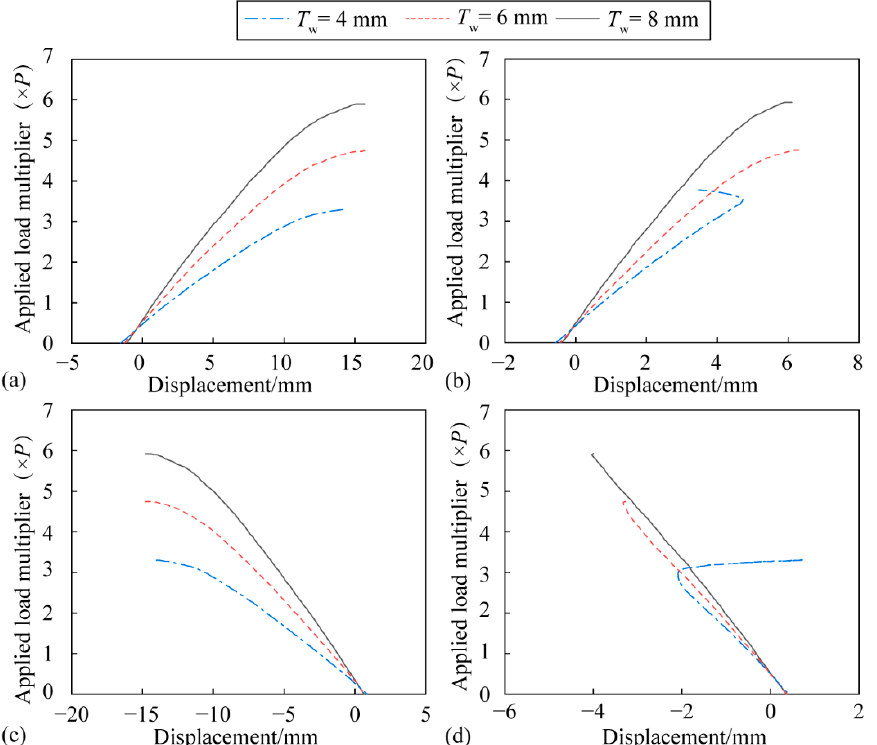
Figure 18. ( a ) Vertical displacement on the top flange, ( b ) horizontal displacement on the front web of the point in the juncture node zone, ( c ) vertical displacement on the top flange, ( d ) horizontal displacement on the front web of the point in the curved zone due to the change in the thickness of the web.